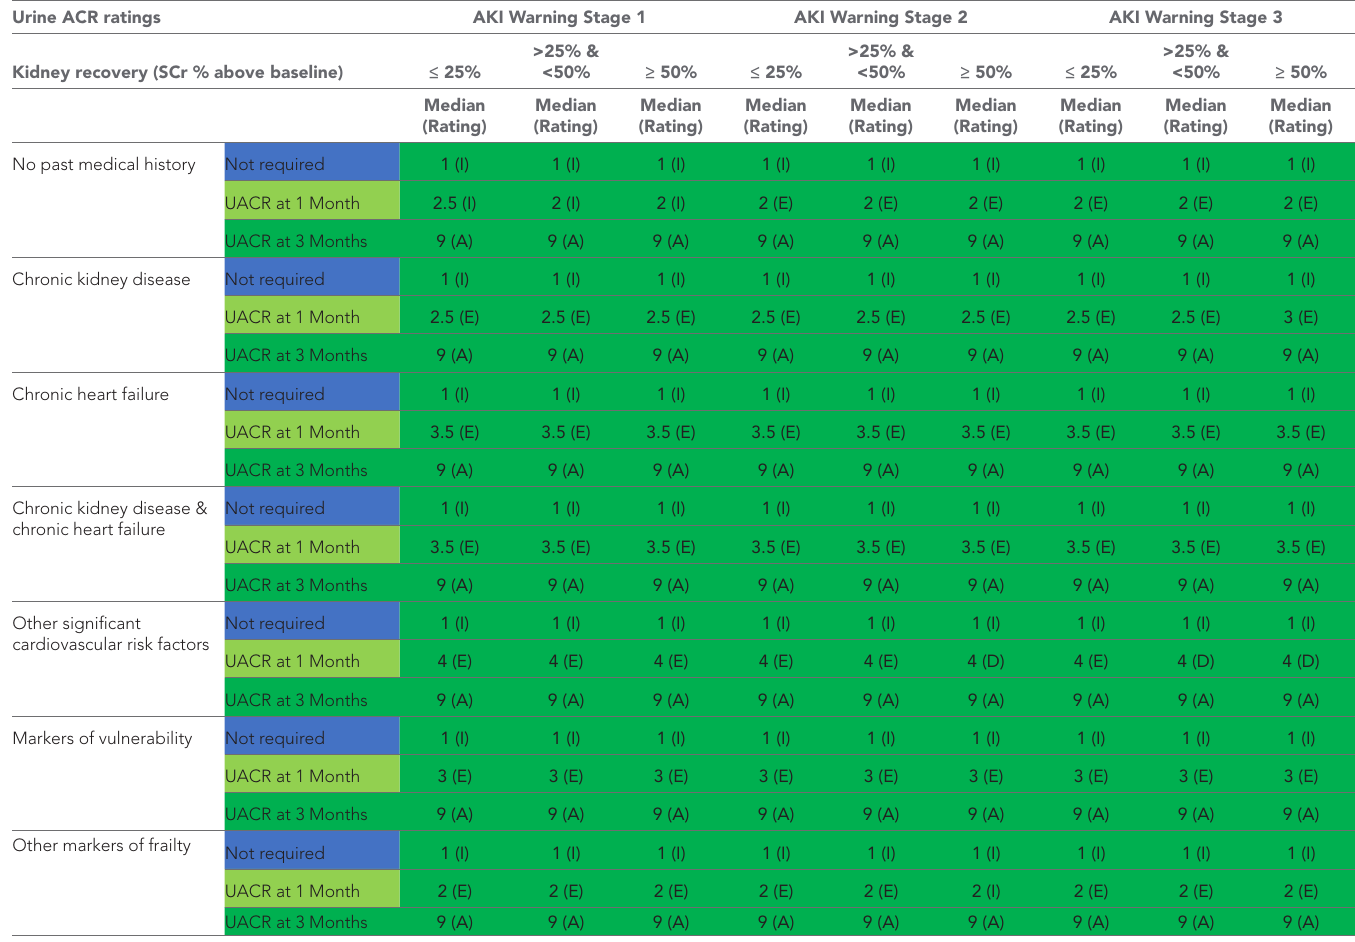
Table 5 Summary of timeliness for performing the first post- discharge urine albumin- to- creatinine ratio. Urine ACR